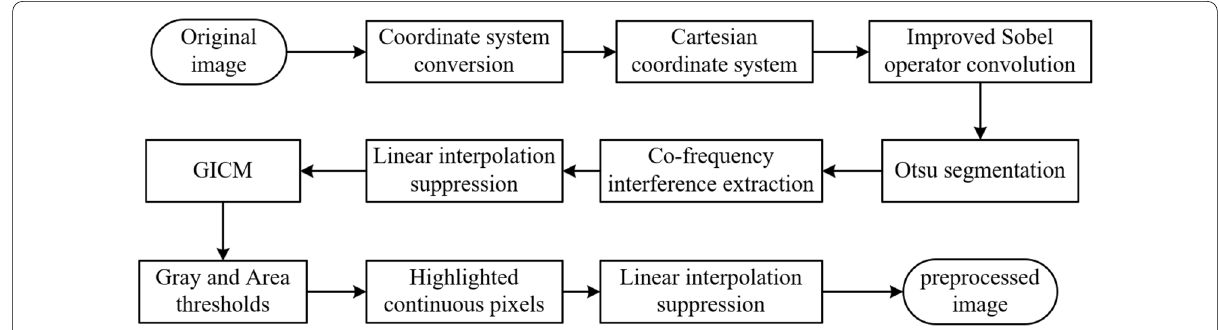
Fig. 2 Data preprocessing procedures